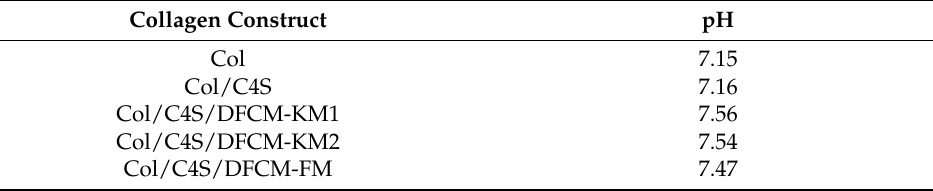
Figure 2. IR transmittance spectra of the constructs (( A ): Col; ( B ): Col/C4S; ( C ): Col/C4S/DFCM- KM1; ( D ): Col/C4S/DFCM-KM2; ( E ): Col/C4S/DFCM-FM). All groups showed similar peak pat- terns, which consisted of the functional group O-H bond at 3330–3340 cm − 1 , and amide bands I, II, and III at wavelengths of 1639–1640, 1500–1600, and 1260–1300 cm − 1 , respectively. Table 1. pH of the constructs.